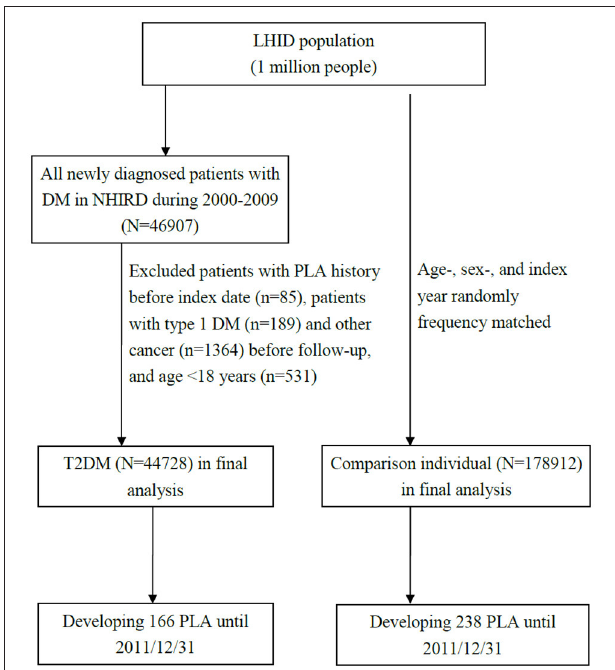
FIGURE 1 | Flow of cohort selection.